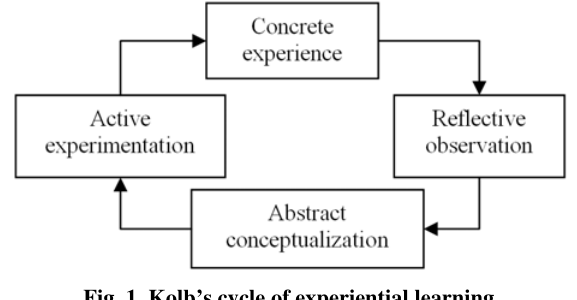
Fig. 1. Kolb’s cycle of experiential learning Source: adapted from Kolb,